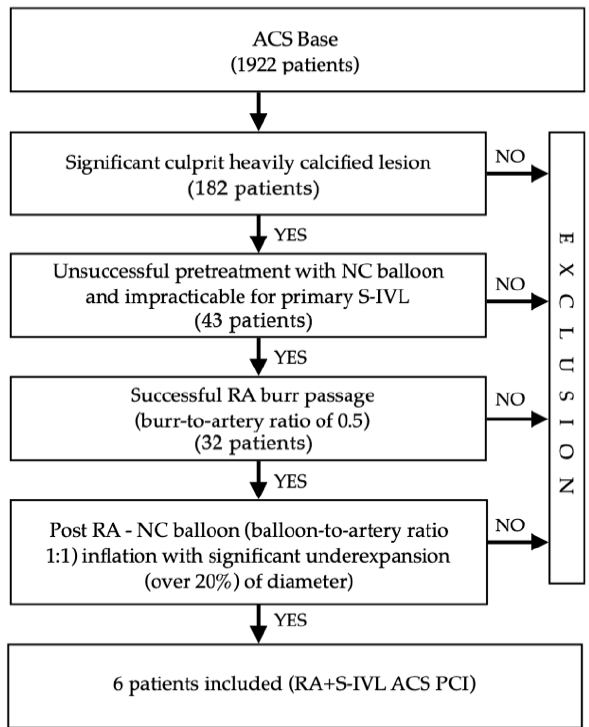
Figure 1. Lesion-related angiographic and procedural inclusion criteria for the study. ACS—acute coronary syndrome; NC—non-compliant; RA—rotational atherectomy; S-IVL—shockwave intravascular lithotripsy; PCI—percutaneous coronary intervention.